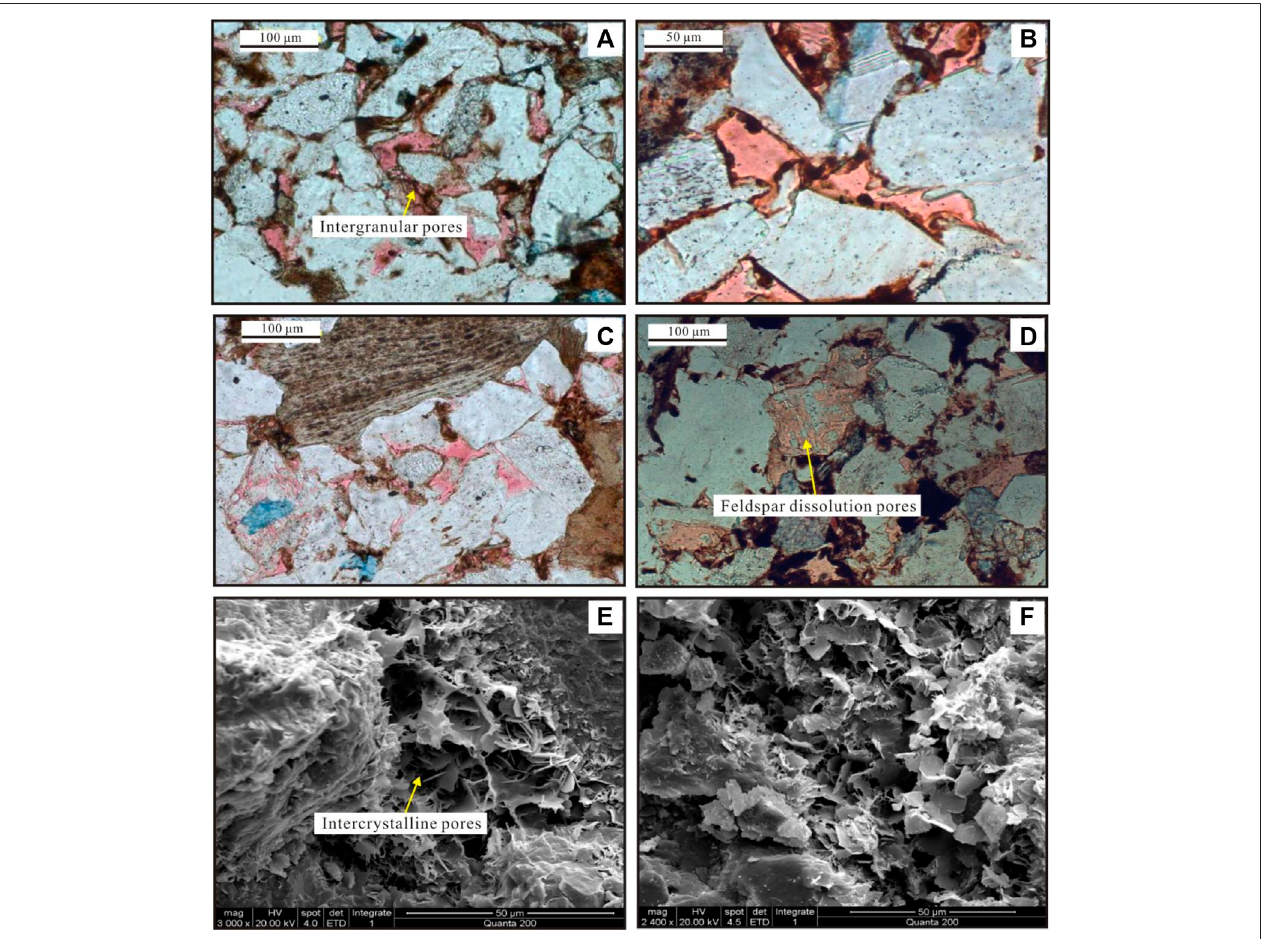
FIGURE4| Development characteristics ofdifferenttypes ofporesinthetargetlayer. (A) Intergranularpores,WellH259,2,191.00 m; (B) Intergranularpores, Well H470, 2,140.8 m; (C) Feldspar dissolution pores, Well H408, 1,960.95 m; (D) Feldspar dissolution pores, Well H284, 2,181.95 m; I Illite and chlorite intercrystalline pores, Well H156, 2,084.28 m; (F) Illite and chlorite intercrystalline pores, Well H72, 2,069.00 m.